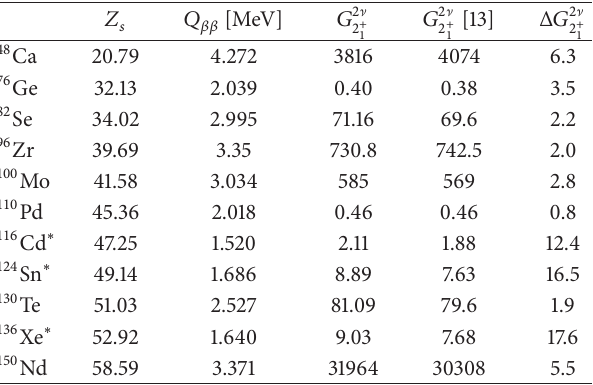
states and 𝐺 2 ] 2 + expressed in yr −1 × 10 21 . Denoted with “ ∗ ” symbol 1 are PSF and deviations corresponding to the nuclei not included